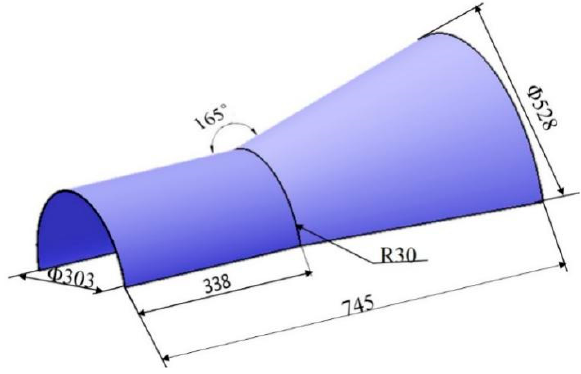
Figure 1. The dimension of large complex thin-wall curvilinear generatrix workpiece.